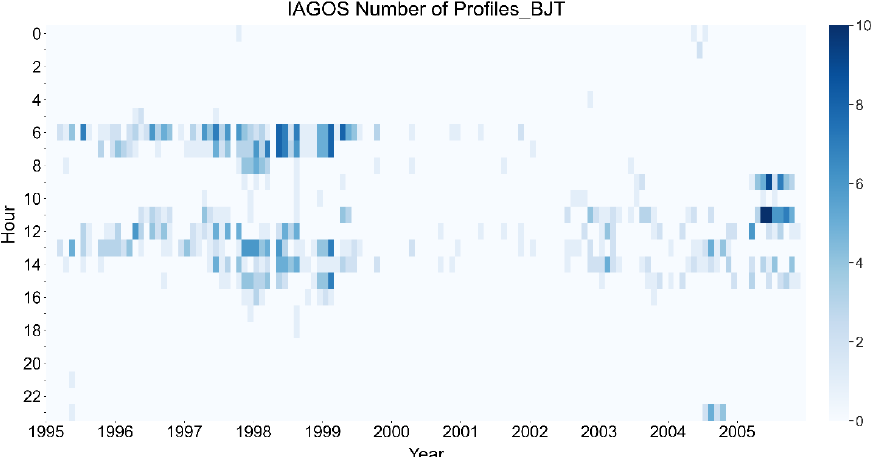
Figure 3. Number of IAGOS profiles in Beijing time (BJT) by hour from 1995 to 2005. After IAGOS data adjustment, the monthly average surface ozone mixing ratio at 14:00 BJT in Beijing measured by IAGOS, ozonesonde and MEE is shown in Figure 5a. The IAGOS ozone data shown is an average between 990 hPa and the surface. The ozonesonde ozone data was averaged below 100 m. Seen from their overlap time from 2001 to 2005, the ozone values of IAGOS data are slightly higher than ozonesonde data. The ozone val- ues in MEE data also are slightly lower than in ozonesonde during their overlapped time